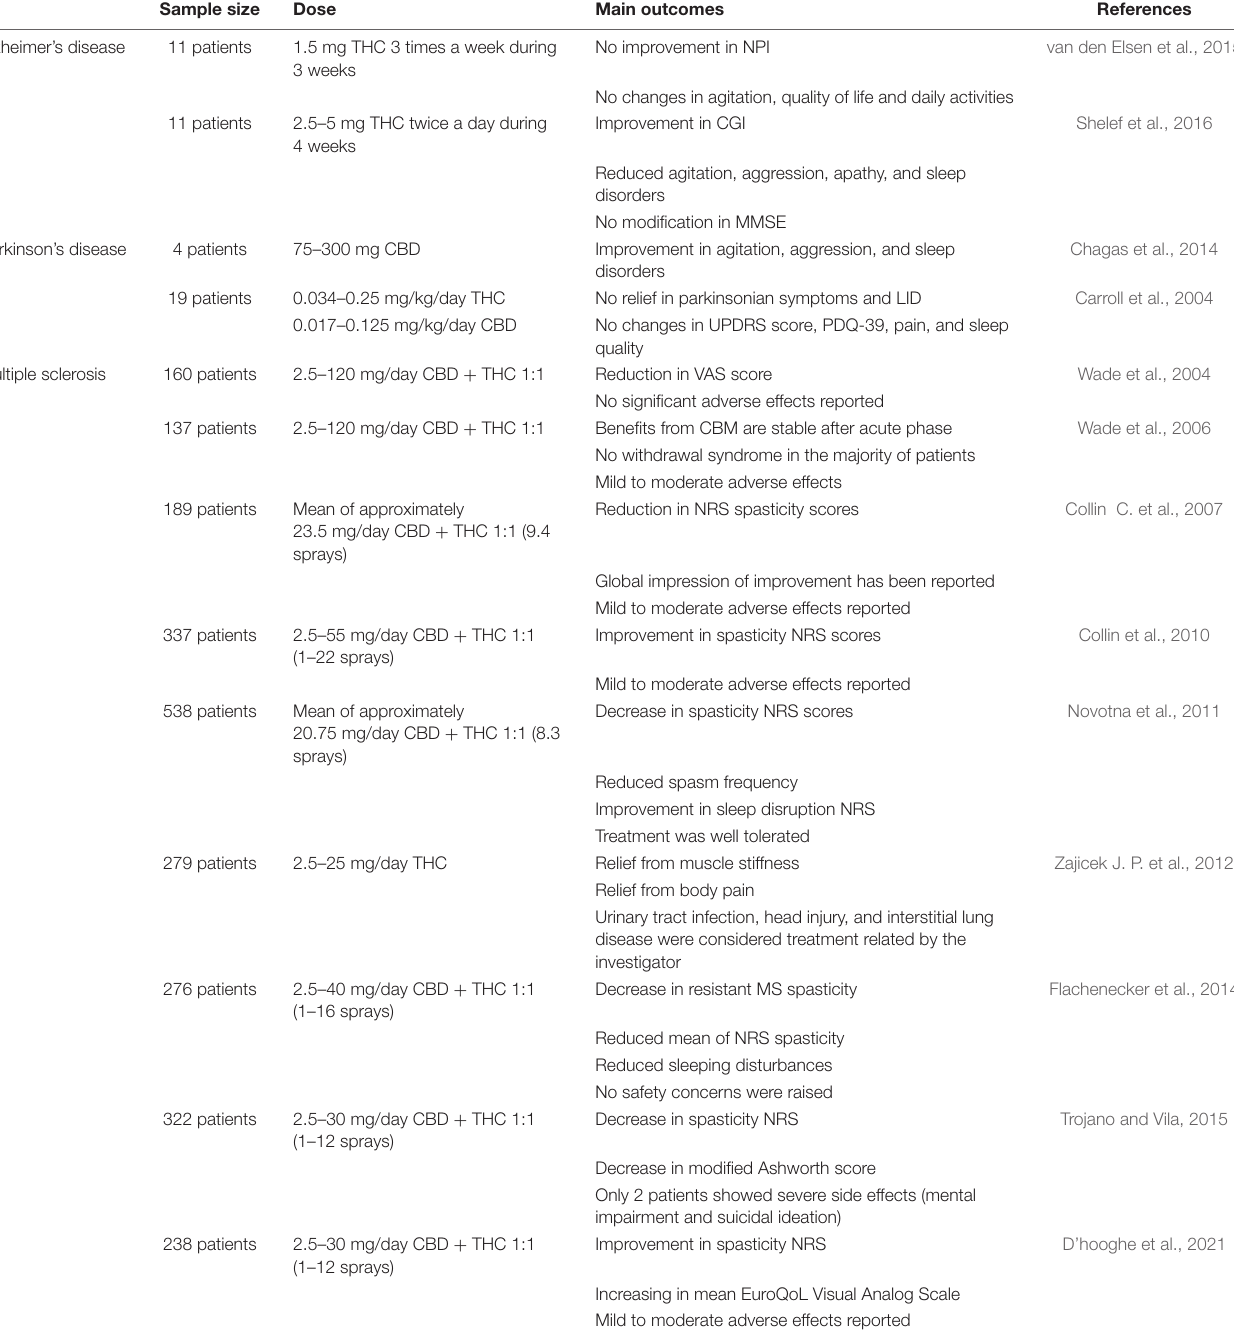
TABLE 1 | Summary of main outcomes from clinical trials using CBM. Sample